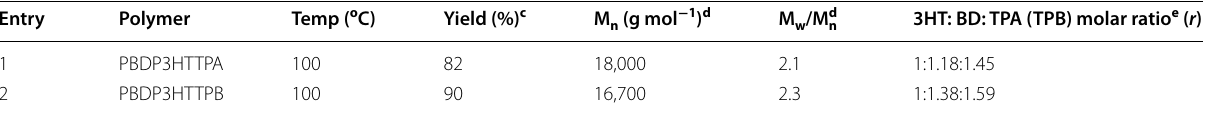
Table 1 Characteristics of hyperbranched conjugated polymers prepared via direct arylation polycondensation of mono- mers 1, 3 and 4 (PBDP3HTTPA) a , and of monomers 2, 3 and 4 (PBD3HTTBP) b